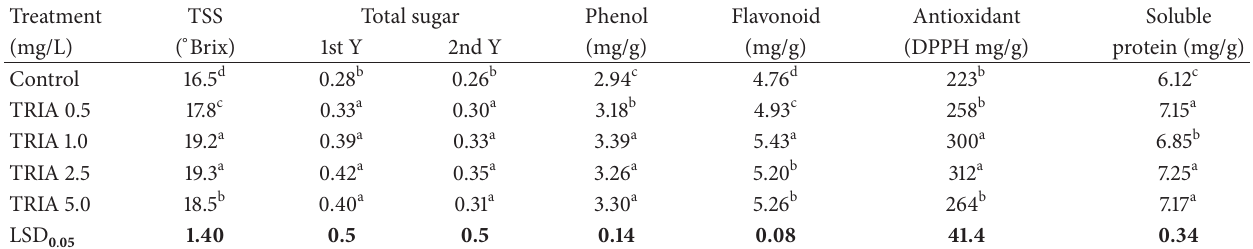
Table 5: The effects of TRIA on phytochemical levels and antioxidant activity in Bougainvillea glabra leaves. Treatment